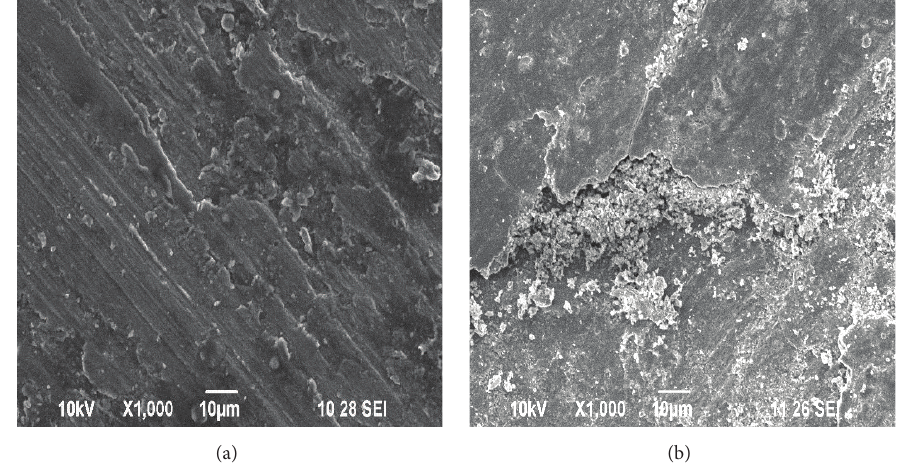
Figure 13: (a) SEM of sample-II at higher magnification before wear test. (b) SEM of wear track of sample-II at higher magnification after wear test (after running 2000 m at 29.43 N load and 4.71m/s sliding